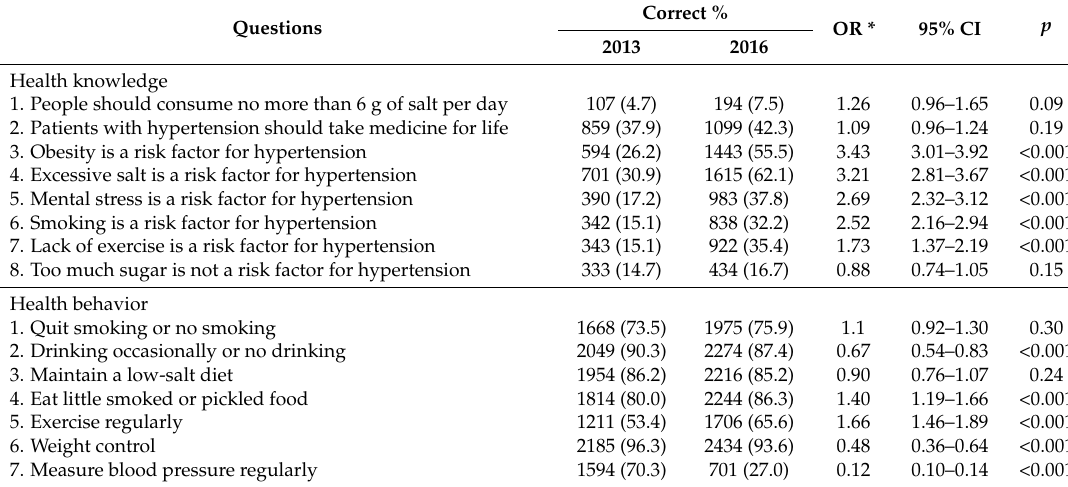
Table 2. The correct rate of hypertension related knowledge and behavior